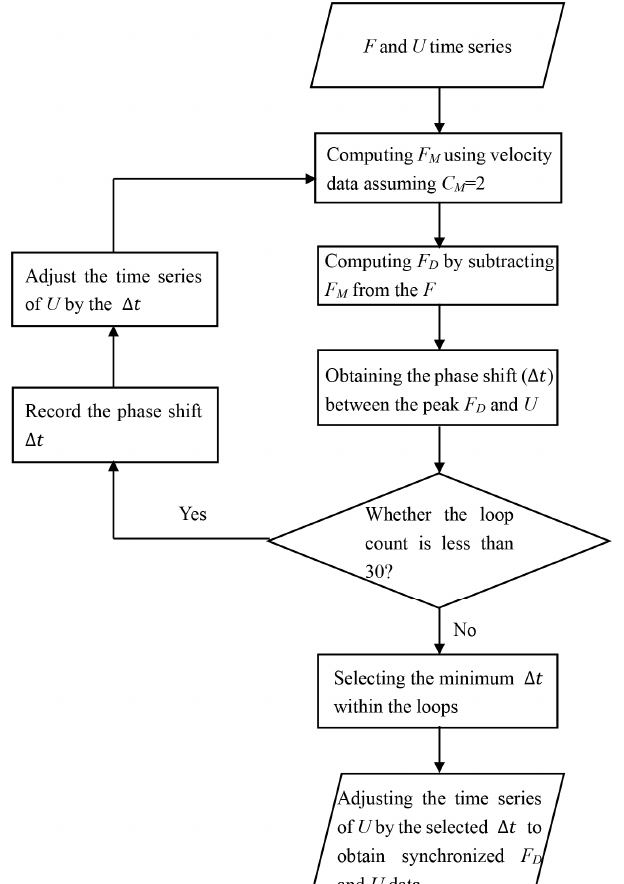
Figure 2. Flow chart to realign velocity and force data signals. The algorithm is provided in the